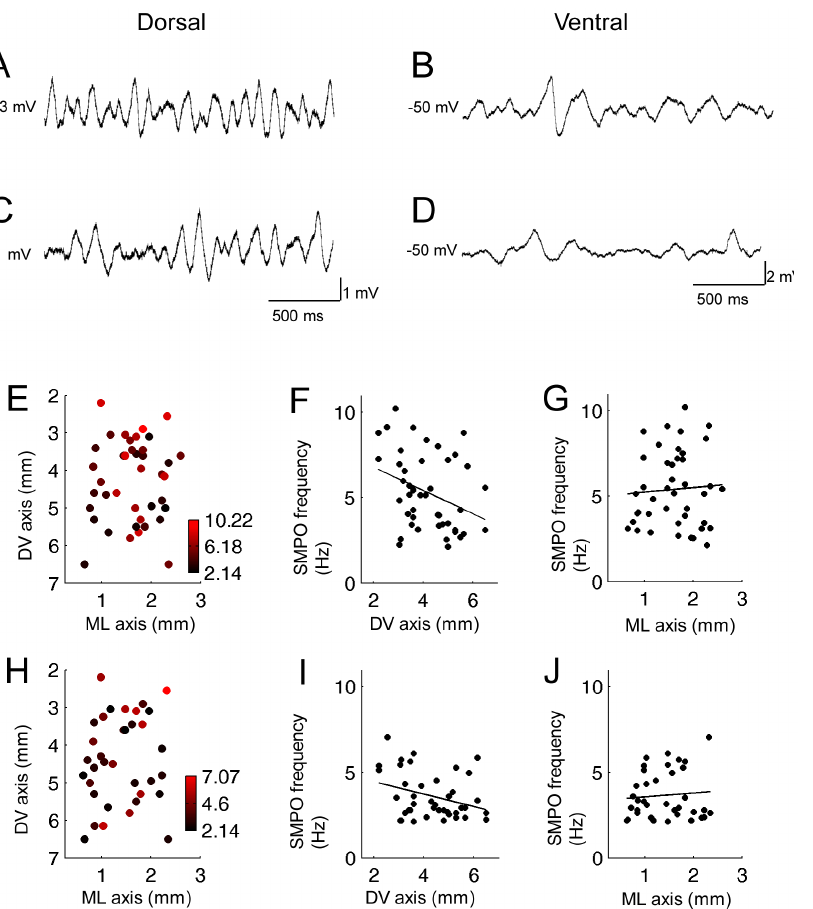
Figure 5. Frequency of subthreshold membrane potential oscillations change systematically along the DV but not along the ML axis. (A and B) Examples of SMPOs in the normal ACSF in a dorsal (A) and a ventral cell (B). The SMPO frequency was higher in dorsal cells than in ventral cells. (C and D) Examples of SMPOs in carbachol (10 m M) in a dorsal (C) and a ventral cell (D). (E) Color plot of the SMPO frequency at different positions in two-dimensions (DV and ML) of anatomical space in normal ACSF. (F and G) SMPO frequency along the DV and ML axis, respectively, in normal ACSF. (E) Color plot of the SMPO frequency at different positions in the two-dimensions (DV and ML) of anatomical space in carbachol. (F and G) SMPO frequency along the DV and ML axis, respectively, in carbachol.